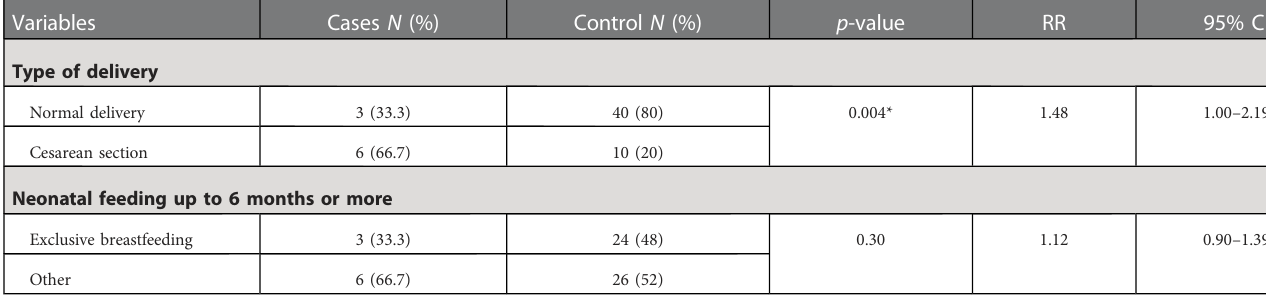
TABLE 5 Relationship between type of delivery and neonatal feeding and functional gastrointestinal diseases.